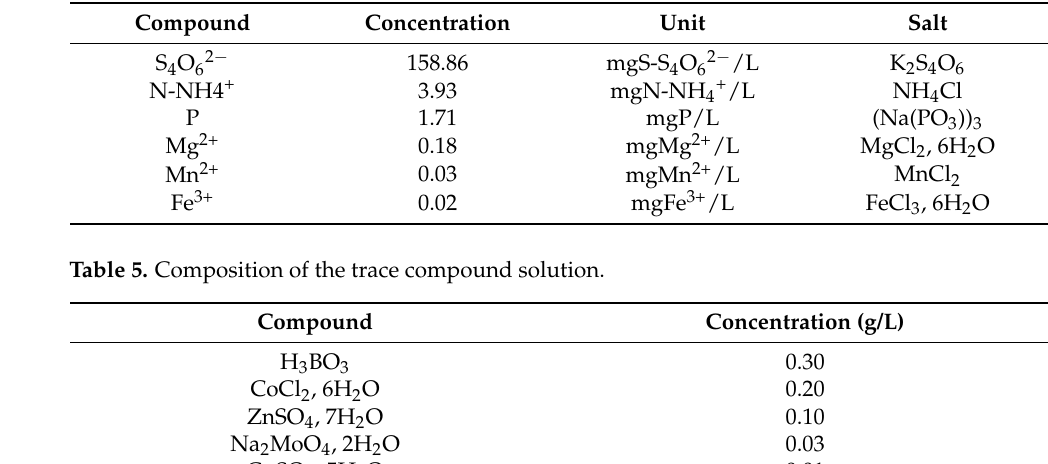
Table 4. Composition of the feeding solution.